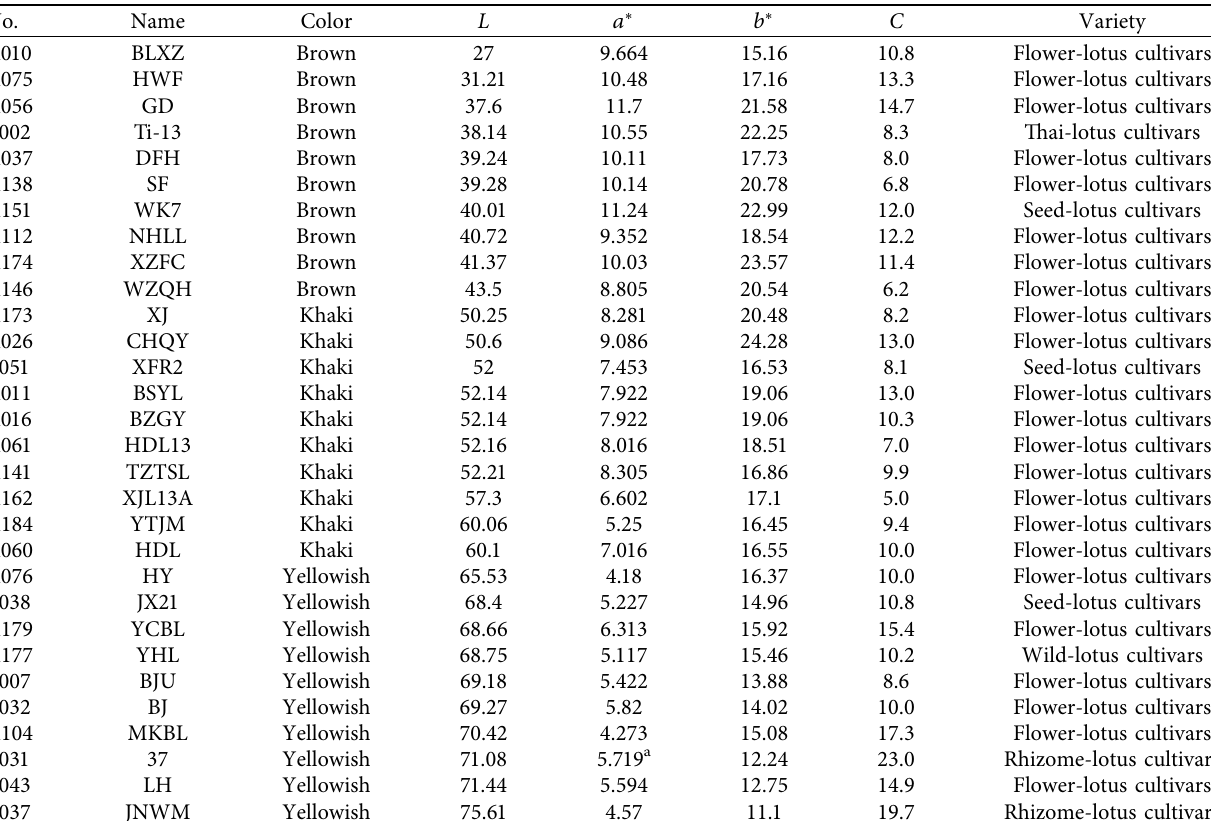
Figure 1: (a) Rhizomes of sacred lotus with different browning degrees, browning degree of 12 representative cultivars (BLXZ(A010), TH(A144), DFH1(A037), XZFC(A174), XFR2(B051), XJ(A173), HDL13(A061), YTJM(A184), MKBL(A104), LH(B043), 37(B031), and YCBL(A179)). (b) Representative samples of lotus root and corresponding slices of dried lotus root (AJN(A003), HXYR(A070), HWL(A073), JSWHO(A082), and JZLYP(A095)). Table 1: Information on the browning of sacred lotus